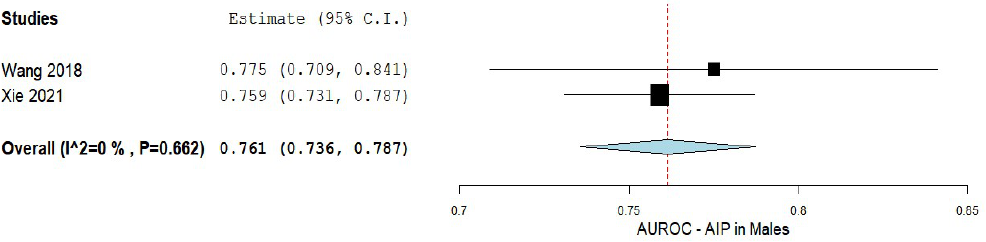
Figure 5. The accuracy of AIP in predicting NAFLD in men. AIP—Atherogenic index of plasma; NAFLD—Non-alcoholic fatty liver disease.